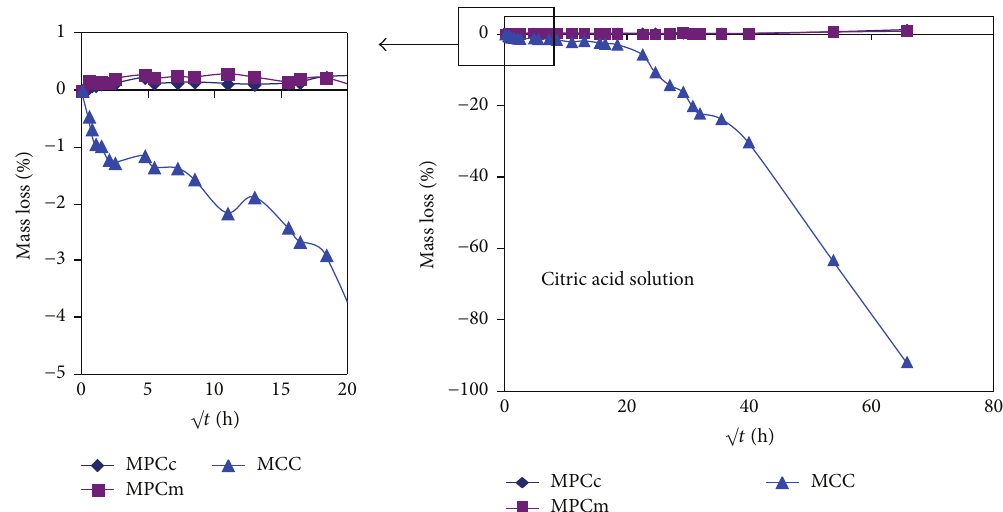
Figure 9: Mass change of microconcretes due to the immersion in citric acid.